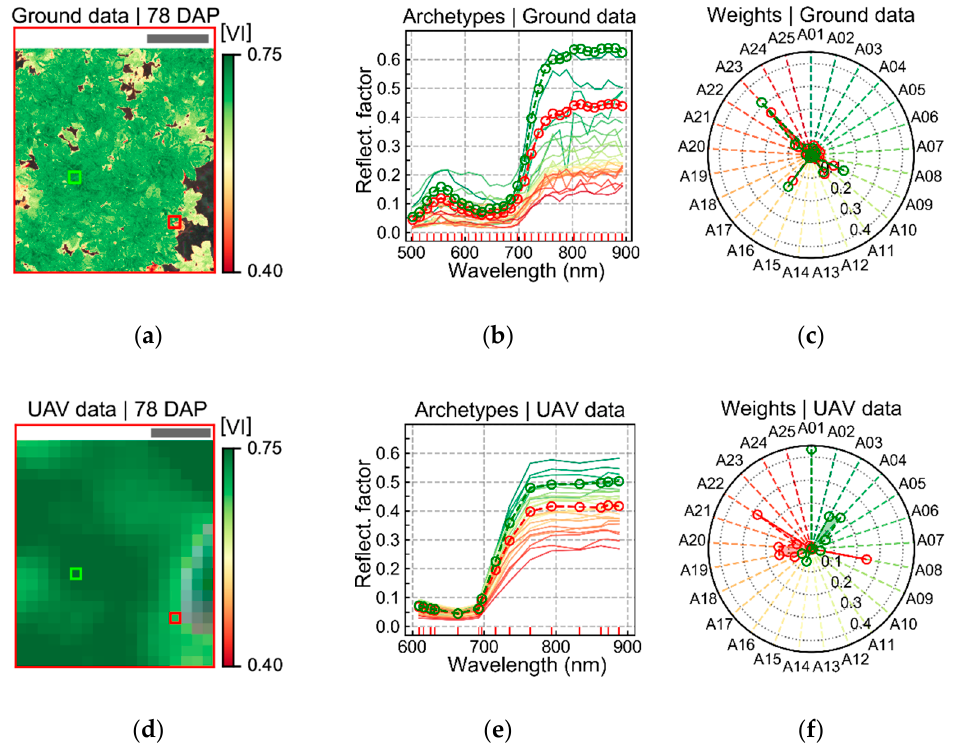
Figure A2. Archetypes derived for ground-based ( b ) and UAV ( e ) images acquired 78 DAP (color coded from green to red according to average reflectance in the NIR). In the same graphs ( a , e ) spectra for two pixels selected from a UAV image patch corresponding to T2 (mixed system) are also described (green and red dashed lines with dots). The weighting for reconstruction of these spectra based on the archetypes are described in the radar plots for the ground-based ( c ) and UAV ( f ) data. The areas (green and red squares) corresponding to the selected UAV pixels ( d ) in the ground-based image ( a ) had their spectra and weights extracted and averaged to represent comparable information to that obtained for UAV data. Colors on ( a ) and ( d ) indicate values of OSAVI (Vegetation Index, Table A2; VI) for the segmented vegetation. Table A5. Distribution of scores given at sampling unit level during disease assessment. Number of sampling units (SUs) assigned to a given class are indicated for each acquisition date, together with the number of imaged SUs using the spectral sensor in handheld mode (in parentheses). Numbers in red indicate SUs not used for evaluating the effects of different disease severity classes on the crop spectral response (see section 2.8).